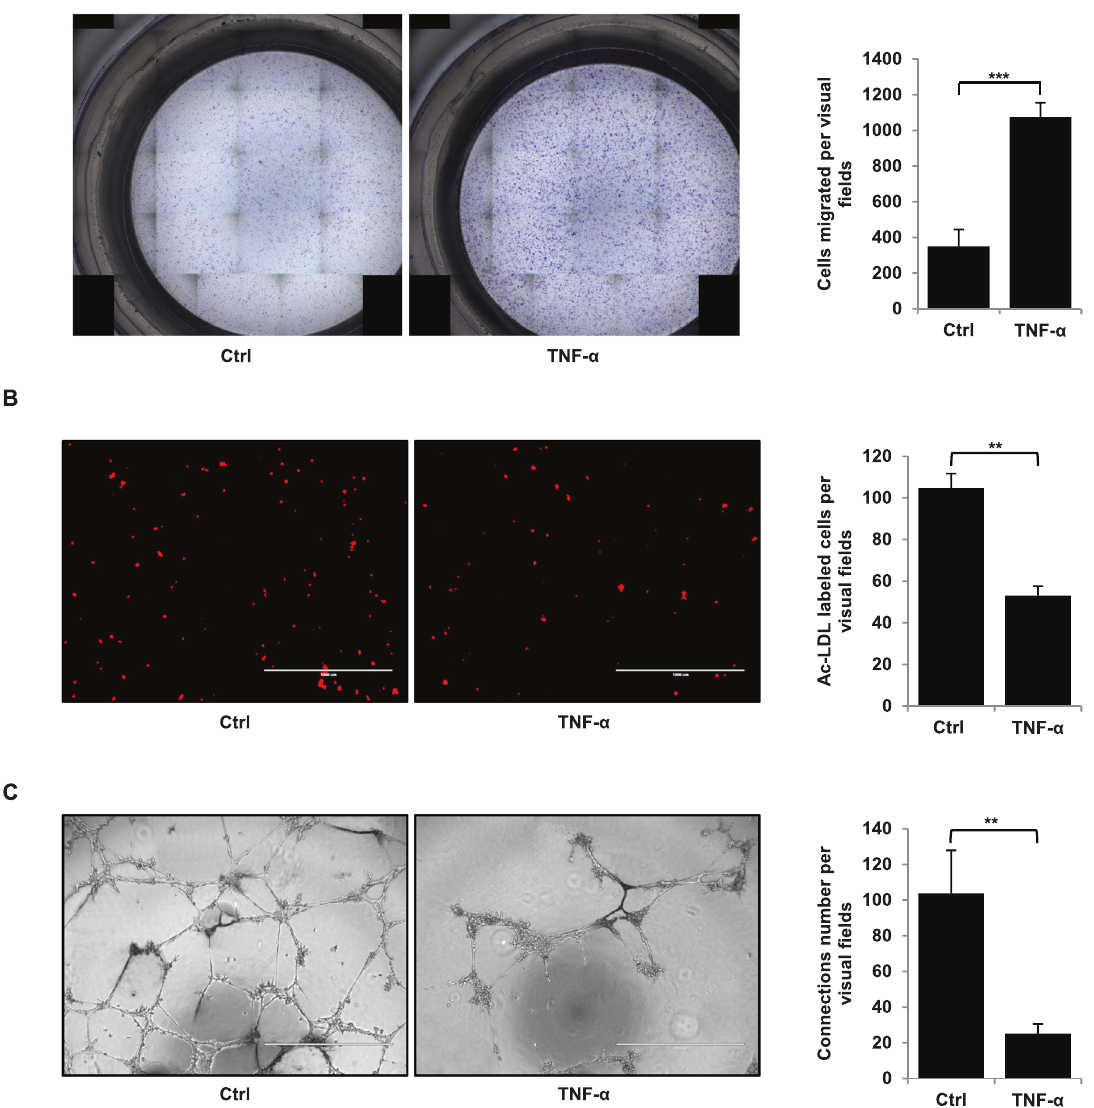
Fig. 2 Effects of TNF- α on cellular migration and angiogenesis. A TNF- α increases HMVECs migration. HMVECs were treated or not for 96 h with 100 ng/ml of TNF- α and were allowed to migrate in a modi fi ed Boyden chamber assay for an additional 3 h30. B TNF- α decreases the number of Ac-LDL-labelled endothelial cells. C TNF- α induces a reduction in tubules formation in a matrigel-based tube-formation assay. Tube formation and Ac-LDL scores were measured for three fi elds. Scale bars, 1000 µm. Migration was measured for six fi elds. Similar results were obtained in three different experiments. Signi fi cant differences are indicated by solid lines (** P < 0.05, *** P < 0.005 by t test). HMVEC human microvascular endothelial cell, Ctrl control, TNF- α tumour necrosis factor- α